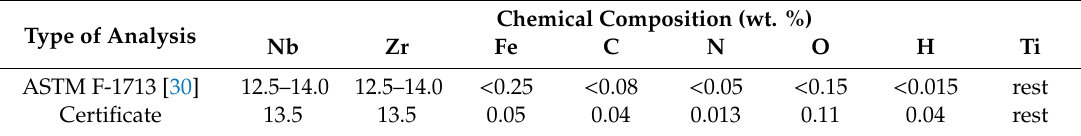
Table 1. Chemical composition of the Ti–13Nb–13Zr alloy.